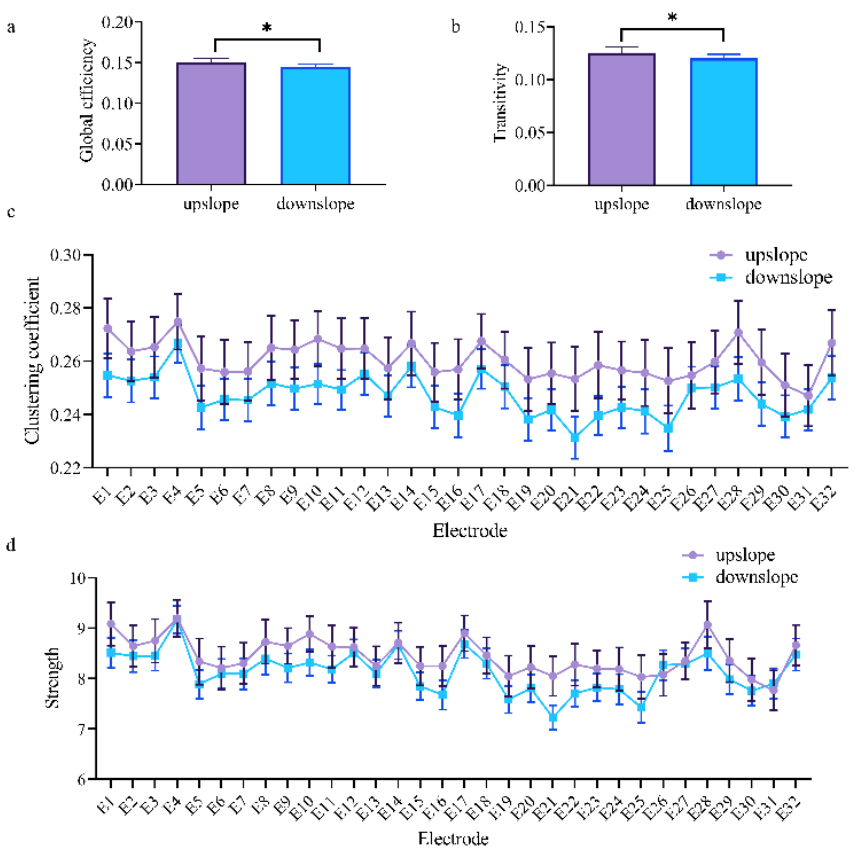
Figure 6. Indexes of the brain network for the two locomotion states in the alpha band (7–13 Hz). ( a , b ) Global indexes of the brain network, including global efficiency and transitivity. ( c , d ) Local indexes of the brain network, including clustering coefficient and strength. All error bars indicate the 95% confidence interval of the mean. * p < 0.05.